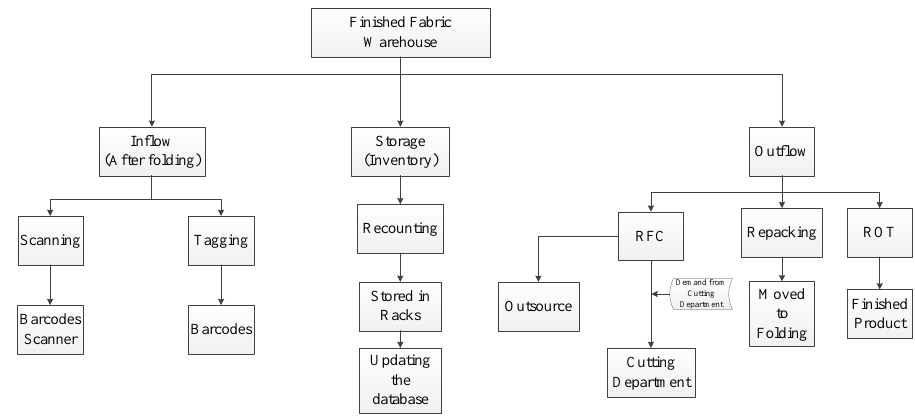
Figure 6. Existing workflow of the warehouse used for the case